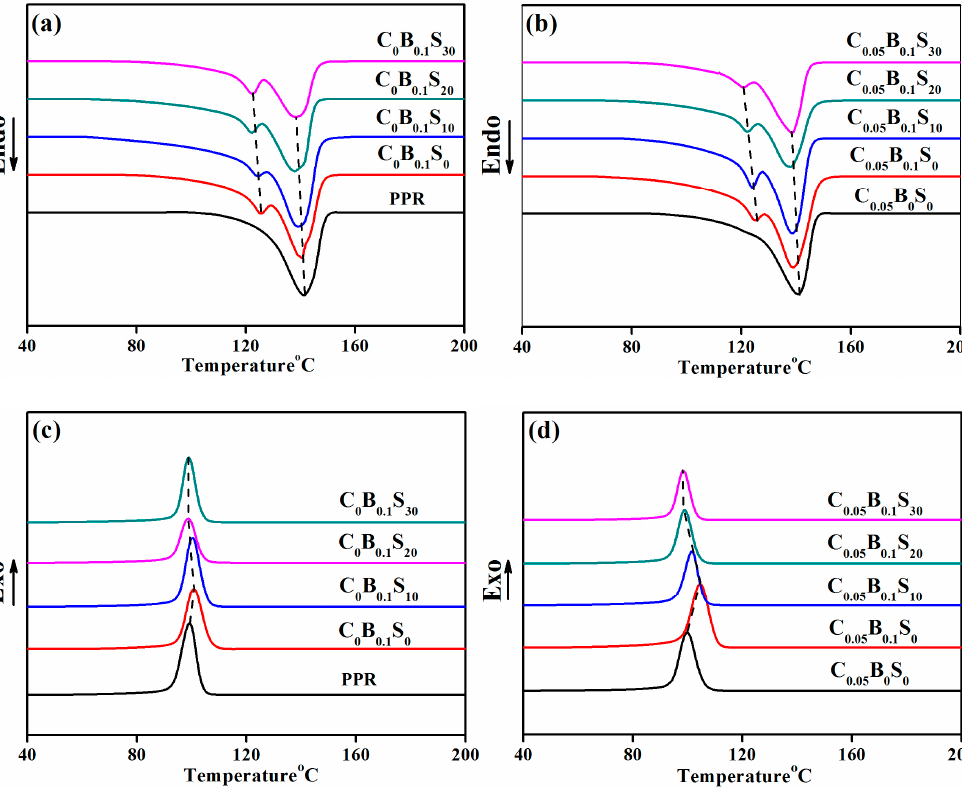
Figure 4. The melting ( a , b ) and crystallization ( c , d ) curves of PPR and its blends. Table 2. Crystallization parameters of the PPR and its blends from DSC results.